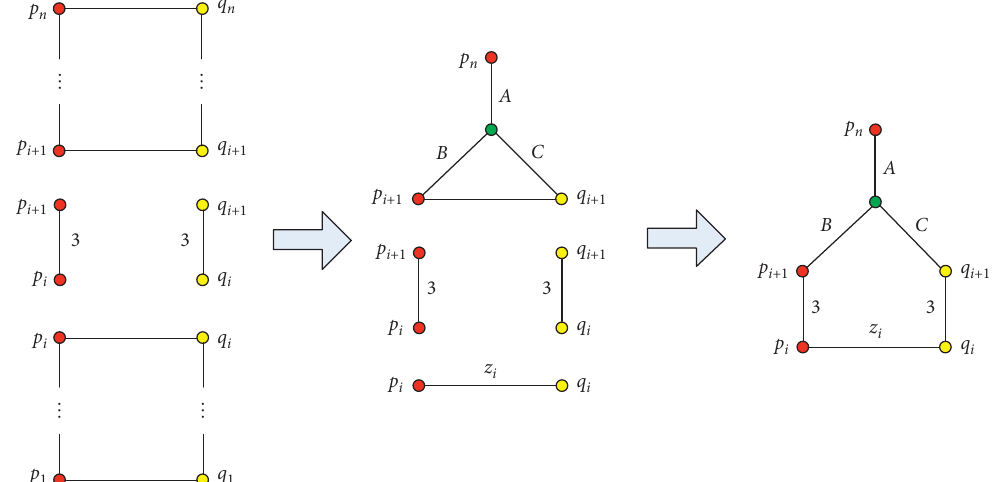
Figure 5: The network Q ∗